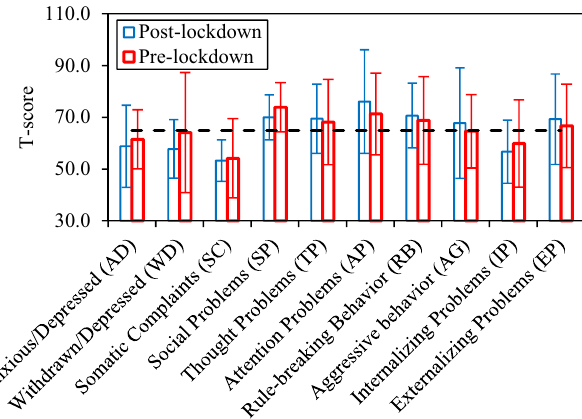
Figure 3. Comparison of T-score ratings of CBCL pre- and post-lockdown.